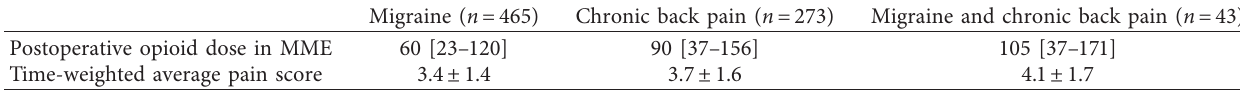
Table 2: Opioid dose requirement and time-weighted average pain scores during 48 hours